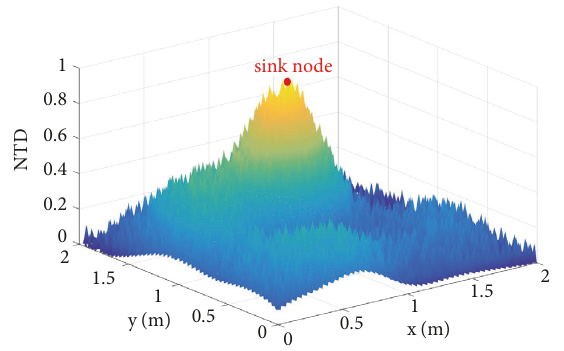
Figure 6: Network traffic distribution (NTD) generated by the proposed cascading model ( 𝛼 = 1